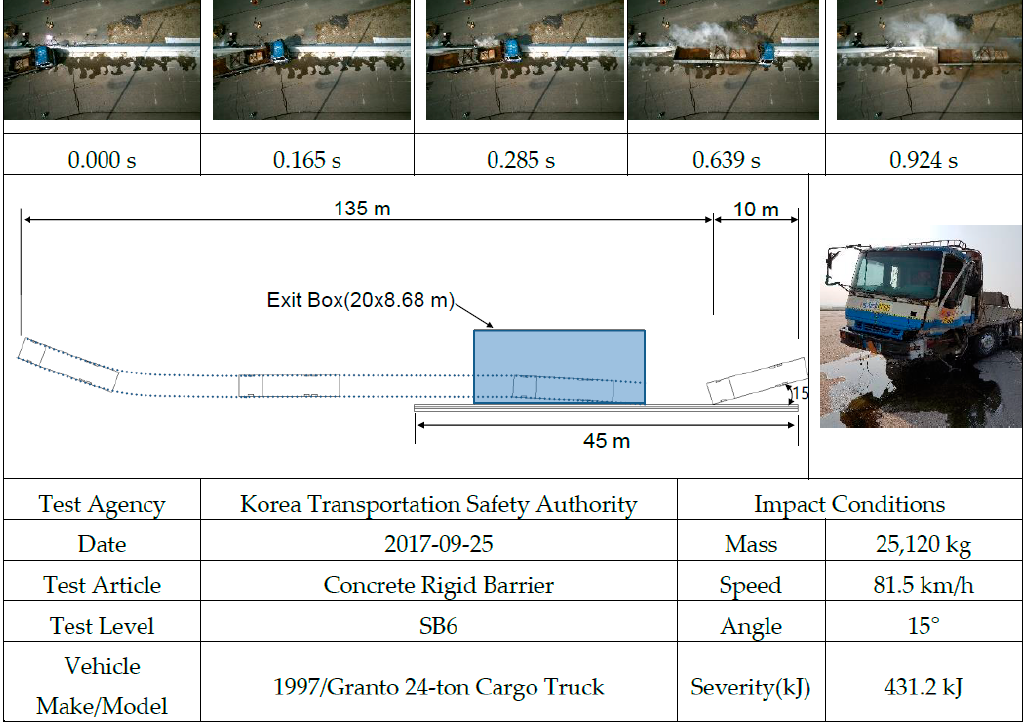
Figure 13. Summary of test results and sequential photographs.